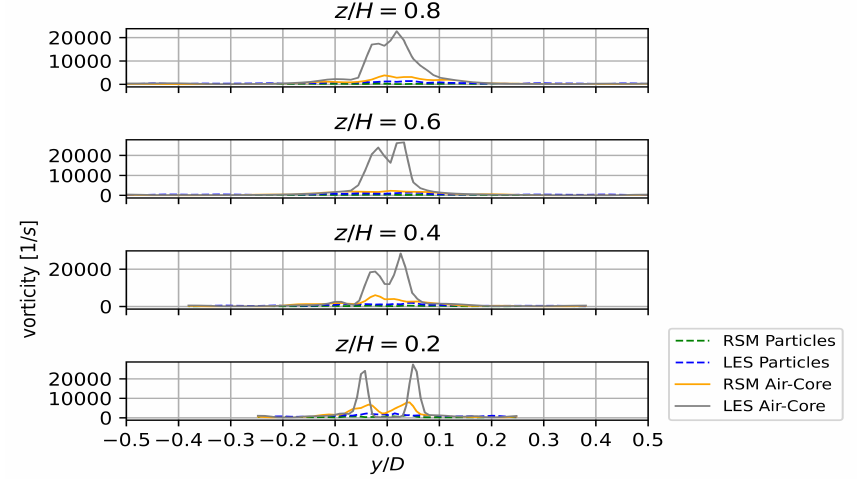
Figure 16. Vorticity magnitude (1/s) for the RSM and LES models as a function of the normalised y co-ordinate at various heights at flow-time 4 s for the simulations with the particles included and at flow-time 2 s for the air-core only simulations.